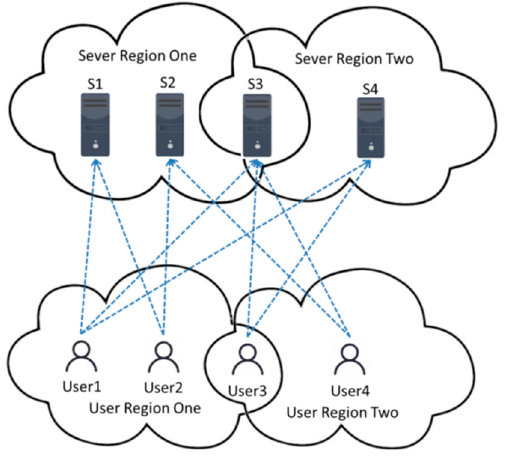
Figure 1. A real game service invocation scenario.